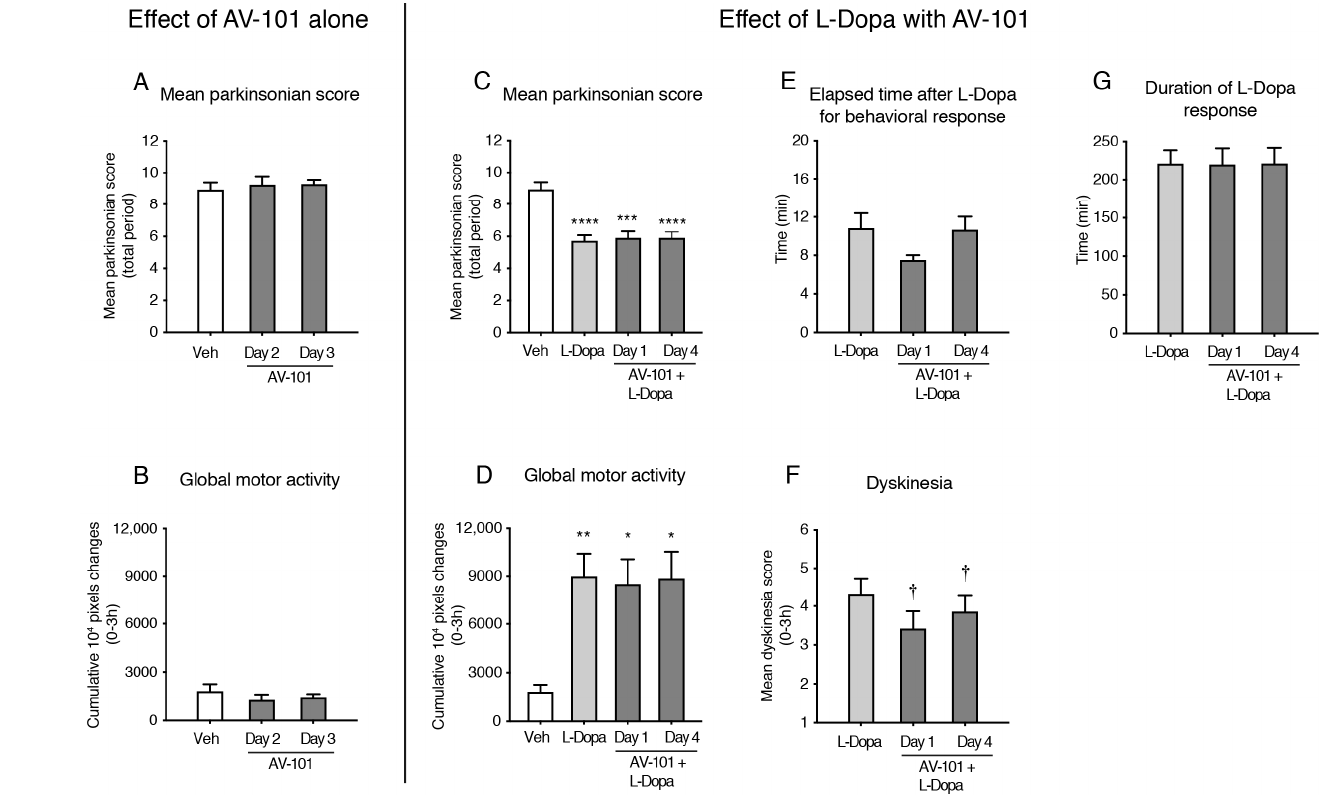
Figure 4. Effect of repeated treatment with AV-101 alone or combined with L-Dopa (main experiment, n = 6). ( A , B ) AV-101 alone did not change the parkinsonian score of the MPTP monkeys nor did it change their motor activity. ( C , D ) L-Dopa improved the parkinsonian score and global motor activity of the animals as compared to the vehicle administration. AV-101 maintained the response of L-Dopa. ( E , G ) AV-101 did not delay the motor response of L-Dopa nor did it change the duration of activity. ( F ) AV-101 at 250 mg/kg reduced the mean dyskinesia scores at the 0–3 h period when added to L-Dopa compared to treatment with L-Dopa alone. * p < 0.05, ** p < 0.01, *** p < 0.001 and **** p < 0.0001 vs. Vehicle; † p ≤ 0.05 vs.